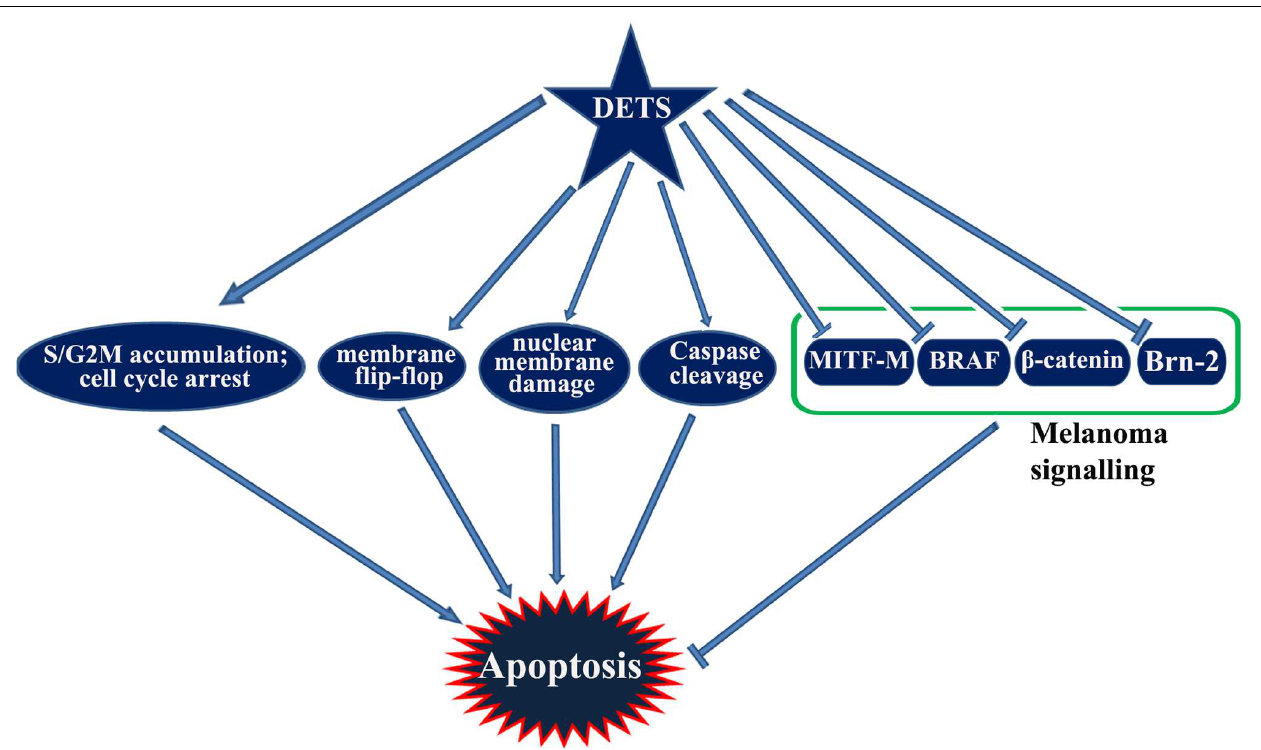
FIGURE 8 | A graphical representation of the